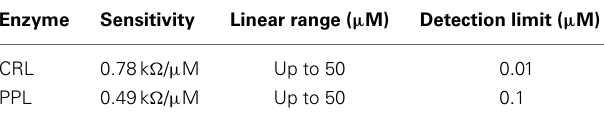
Table 1 | Analytical characteristics of enzymatic